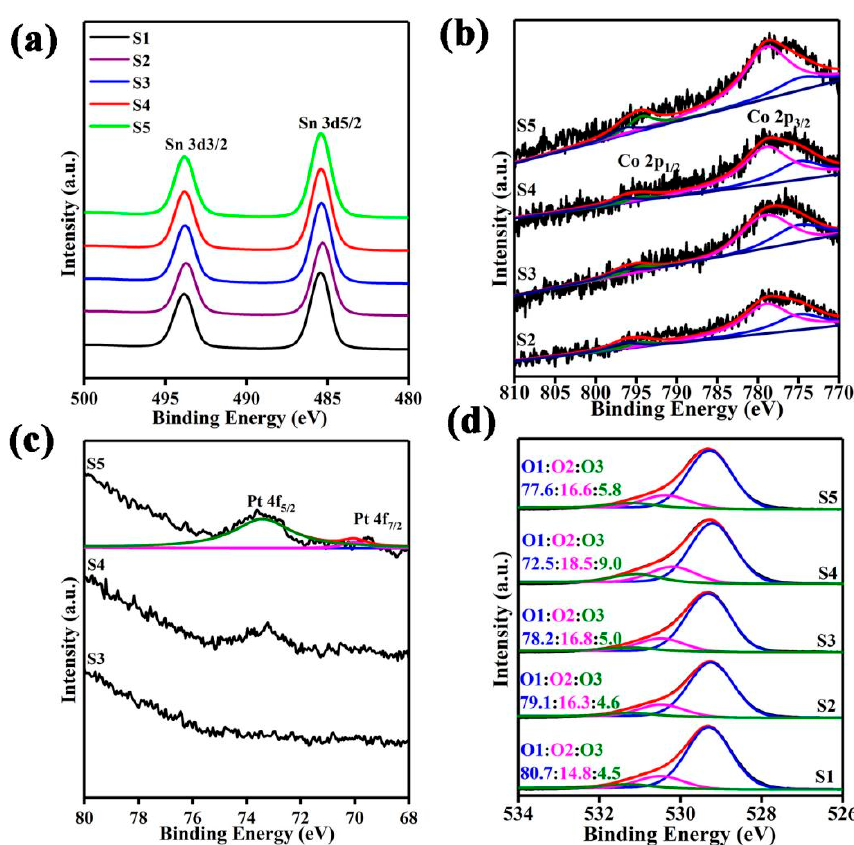
Figure 6. High-resolution XPS spectra of ( a ) Sn 3d, ( b ) Co 2p, ( c ) Pt 4f and ( d ) O 1s in S1–S5.